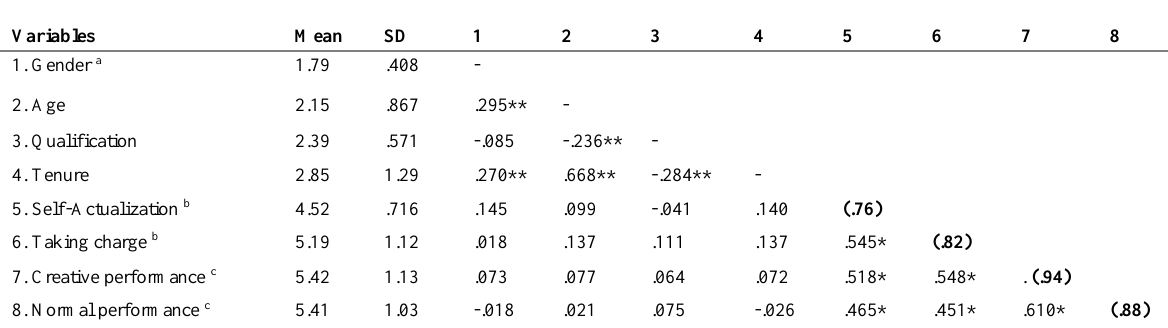
Table 2: Means, Standard Deviations and